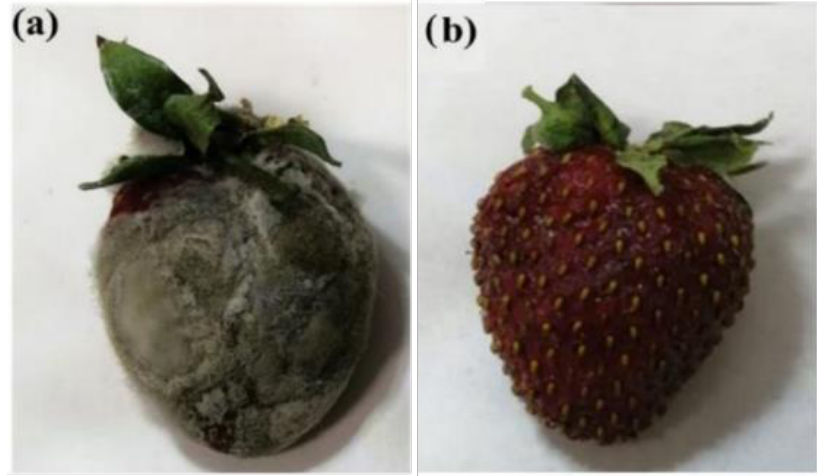
Figure 10. Fresh strawberry: ( a ) uncoated; ( b ) coated with pectin nanocomposite after 10 days of storage at room temperature, RH = 60%. Reproduced with permission from [77].